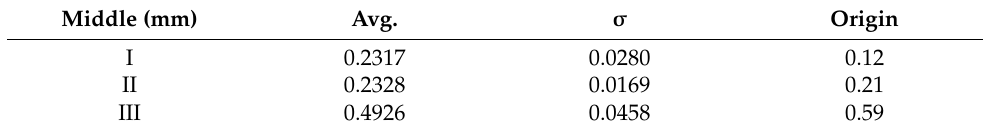
Table 7. Dimensions measured by the optical microscope (OM) from specimens 1 to 6.